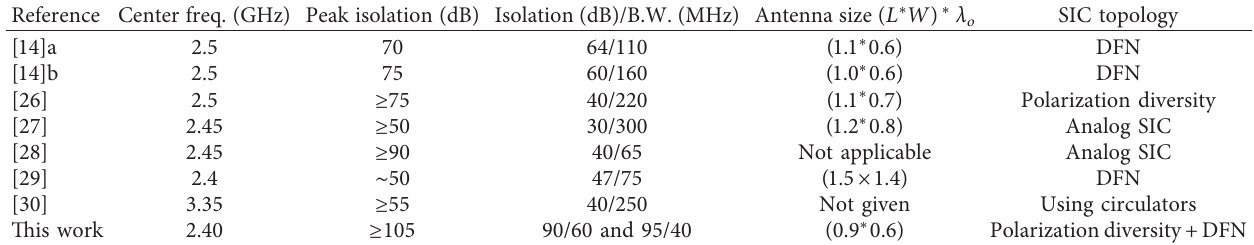
Table 1: The comparison of interport isolation and dimensions of presented antenna with some of the previously reported dual polarized, full duplex antennas [14,